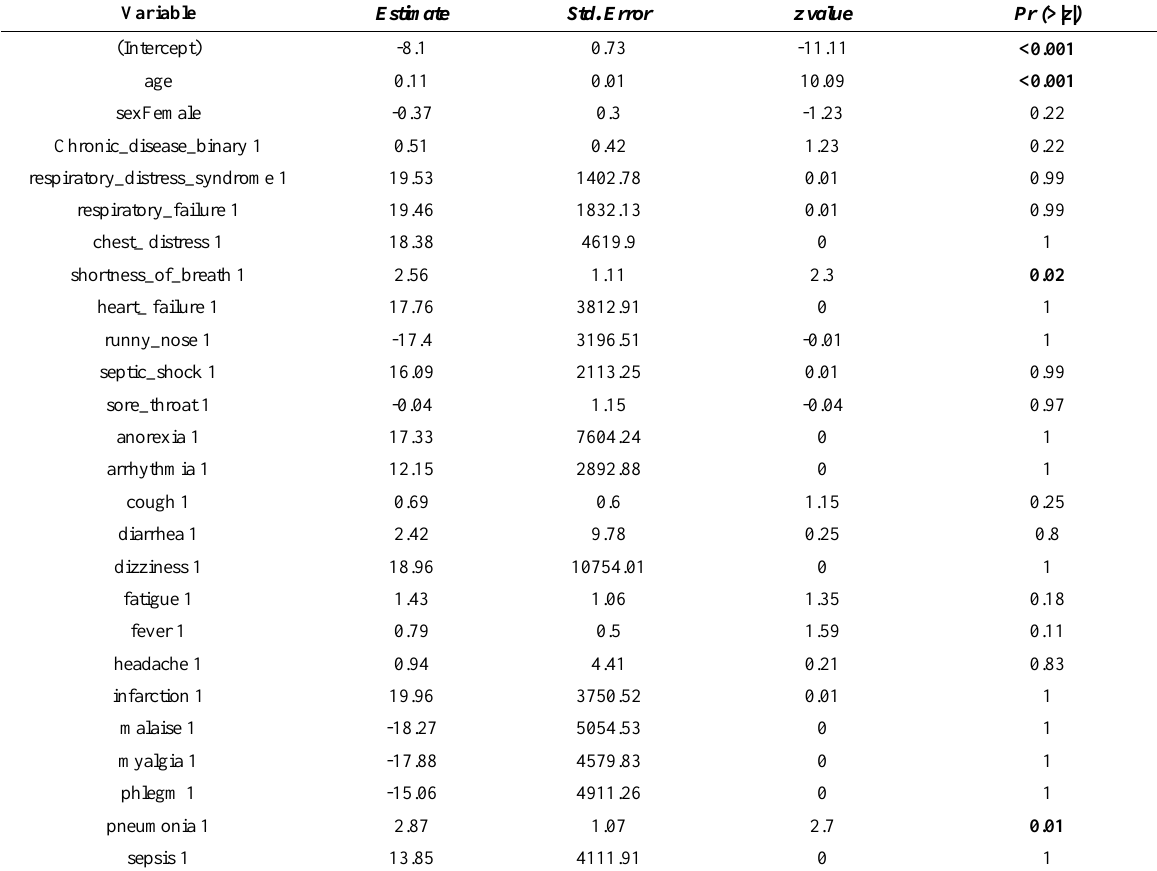
Table 1. Logistic Regression Analysis